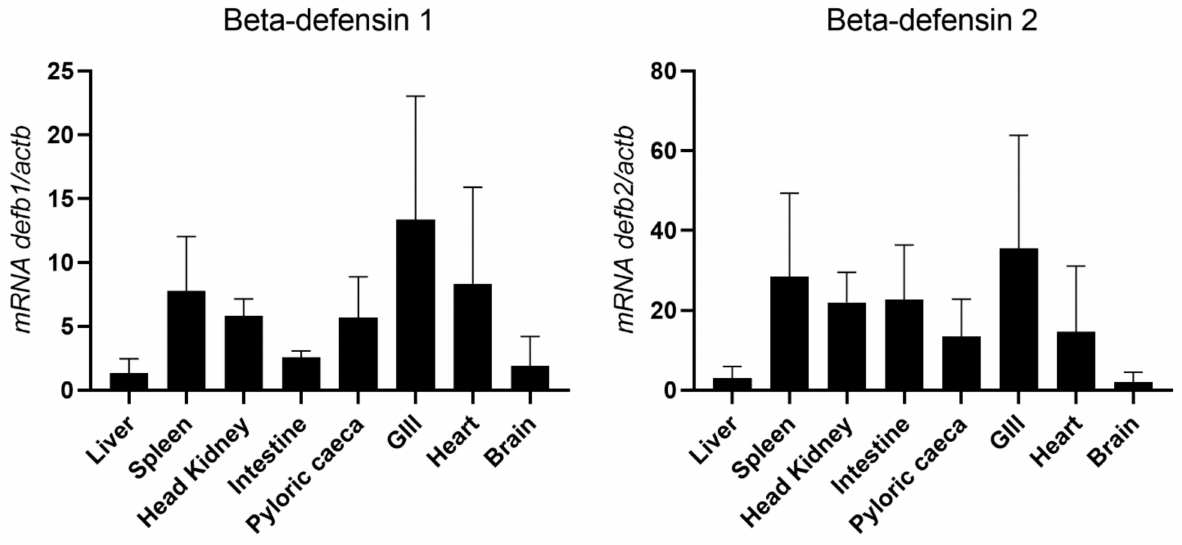
Figure 8. Basal expression of beta-defensin genes in different organs of healthy sea bass, measured by real-time PCR. Each sample was normalized to beta actin ( actb ) calculated by the comparative CT method (2 − ∆∆ CT ). Values are presented as means ± standard deviation (S.D.) ( n =